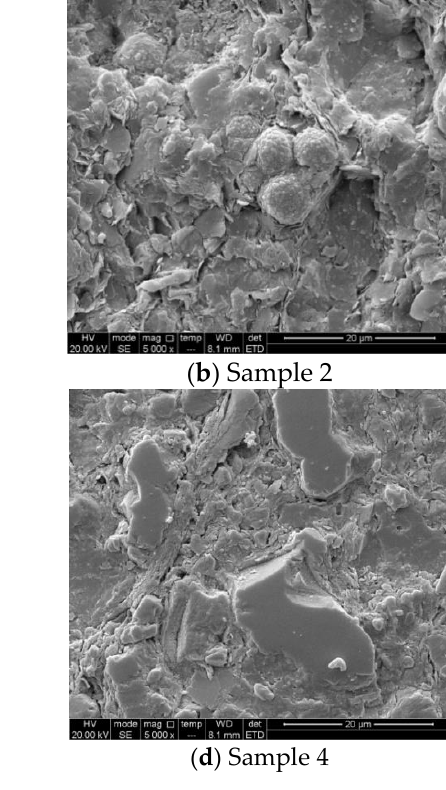
Figure 5. SEM images of four samples.